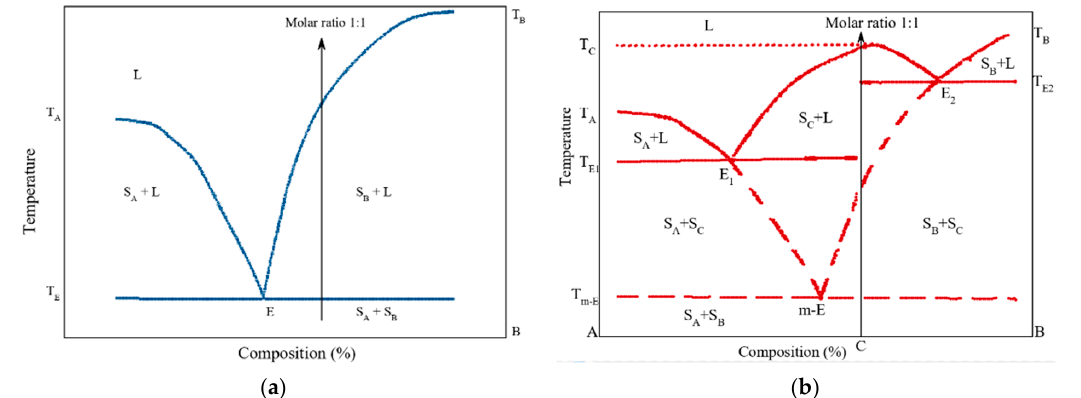
Figure 2. ( a ) Binary phase diagram of a combination incapable of co-crystal formation. ( b ) Binary phase diagrams of co-crystal formation. L, liquid; S A, solid of component A; S B , solid of component B; T E , eutectic temperature; S C , co-crystal; E, eutectic point; m-E, metastable eutectic point; T m-E metastable eutectic temperature; T A , melting temperature of component A; T B , melting temperature of component B; T C , melting temperature of co-crystal. Obtained and replotted from [71,72]. Table 10. Overview of thermal characterization (DSC) of drug co-crystals obtained by ball milling. Other transitions, such as crystallization temperature (Tc) and other endothermic signals, are also reported (along with the articles) and summarized in Table 11. For example,